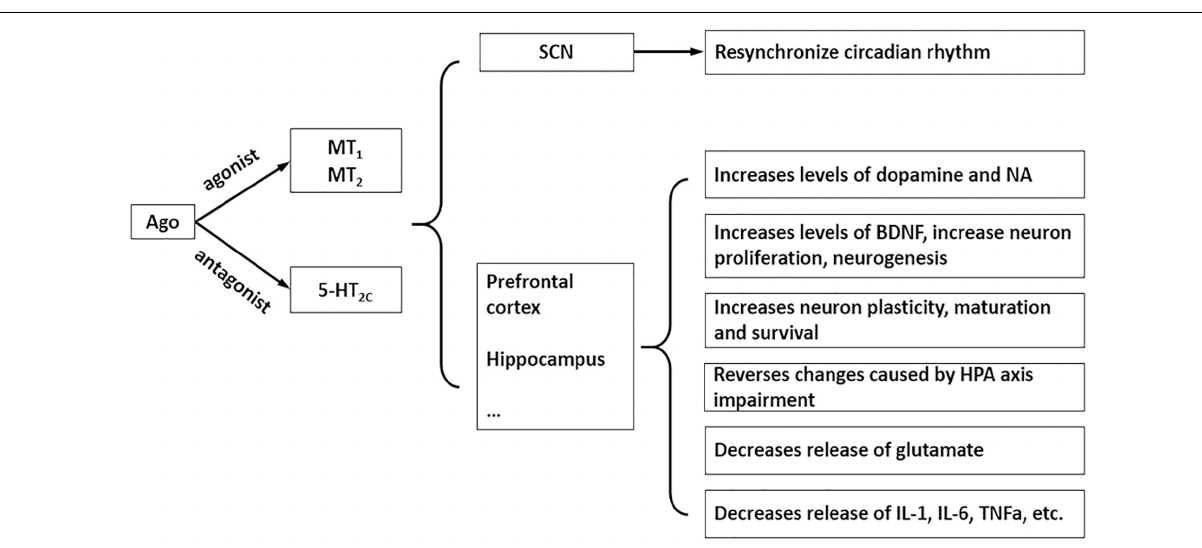
Animal Grouping and